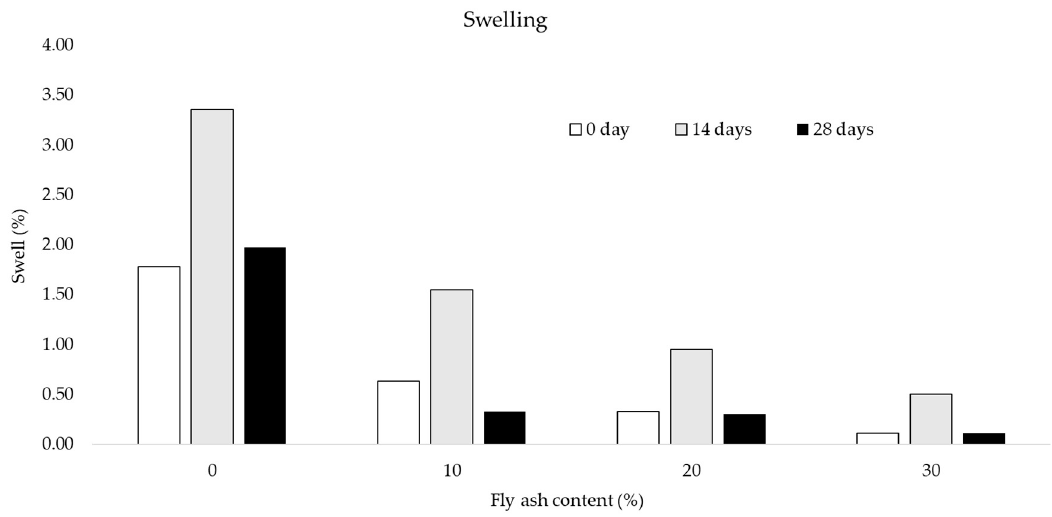
Figure 4. Swell potential at different FA ratios and curing times.